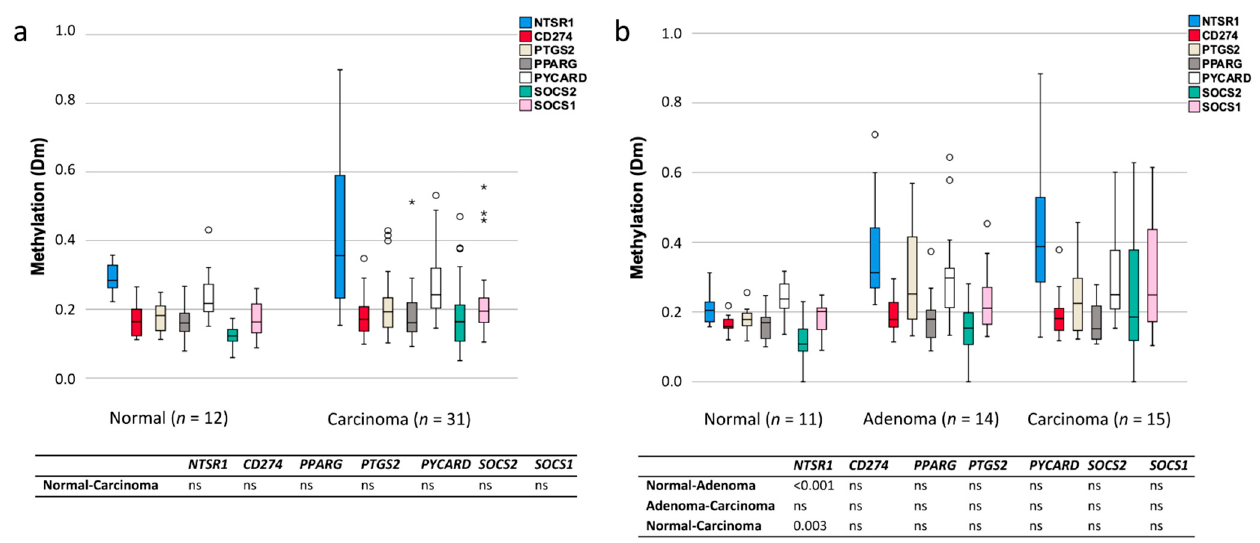
Figure 5. Comparison of the degrees of methylation of inflammation-associated genes in normal colon and tumor specimens. ( a ) Distribution of methylation dosage (Dm) values in CA-CRC samples. ( b ) Distribution of methylation dosage values in LS samples. The upper and lower edges of the boxes are the 75th and 25th percentiles, the horizontal line inside the box indicates the median, the whiskers denote the highest and lowest values, and the asterisks and open circles represent outliers: extreme values and potential outliers, respectively (based on the interquartile range (IQR)). Bonferroni-corrected two-sided p values are presented in the tables below for pairwise comparisons, and ns stands for non-significant p value.